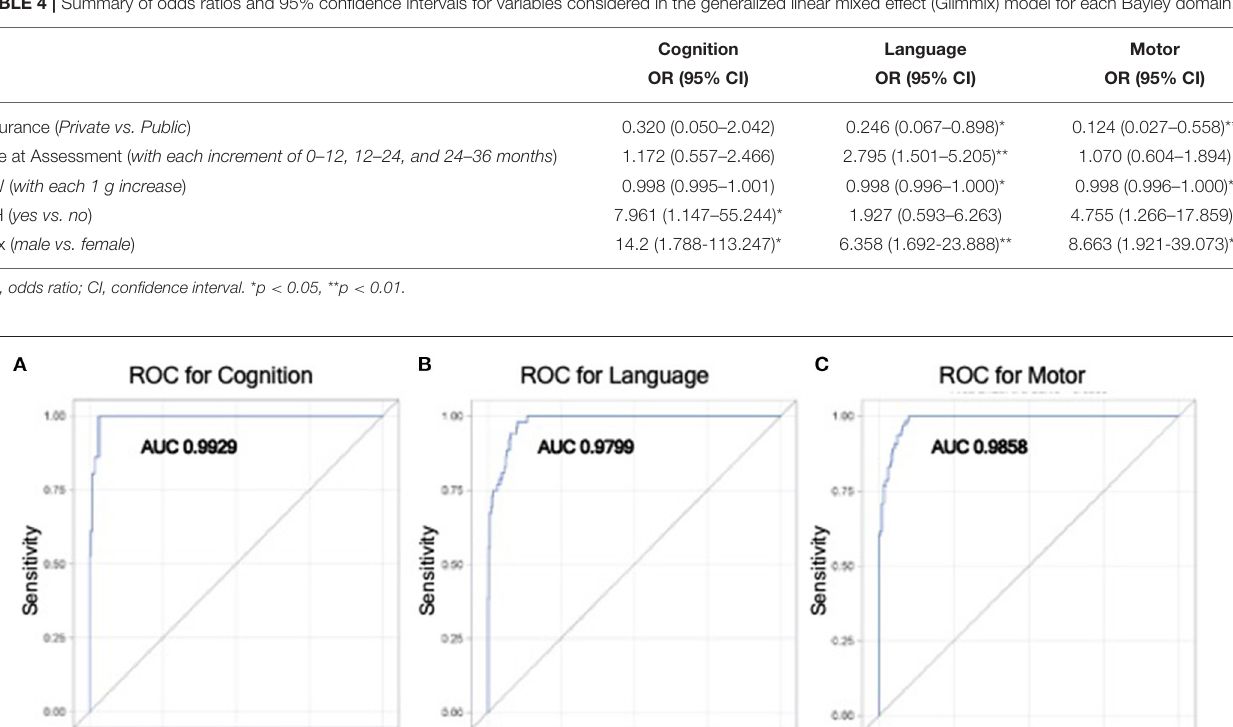
TABLE 4 | Summary of odds ratios and 95% confidence intervals for variables considered in the generalized linear mixed effect (Glimmix) model for each Bayley domain.